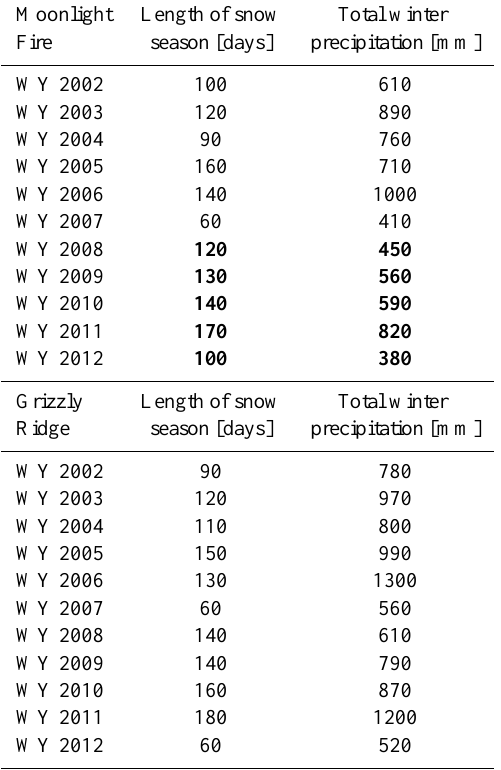
Table 2. Length of snow season compared to total winter precipita- tion for the area of the Moonlight Fire and Grizzly Ridge. Post-fire years are set in